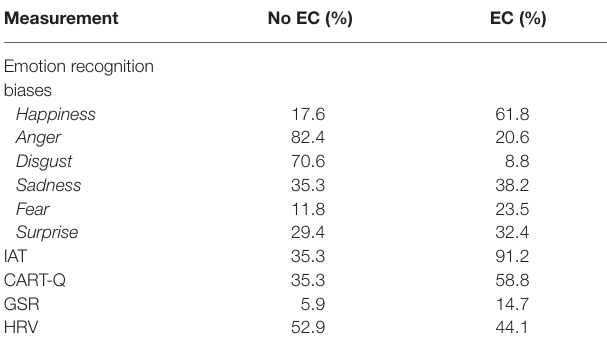
TABLE 1 | The percentages of athletes that showed increases at Week 6 (i.e., at the end of EC) in comparison to Week 0 (i.e., before EC) for the coaches with or without the EC intervention in each measurement, including the emotion recognition biases, the Implicit Association Test (IAT), the Coach–Athlete Relationship Questionnaire (CART-Q), and the galvanic skin response (GSR) and SDNN measure of the heart rate variability (HRV) when viewing the coaches’